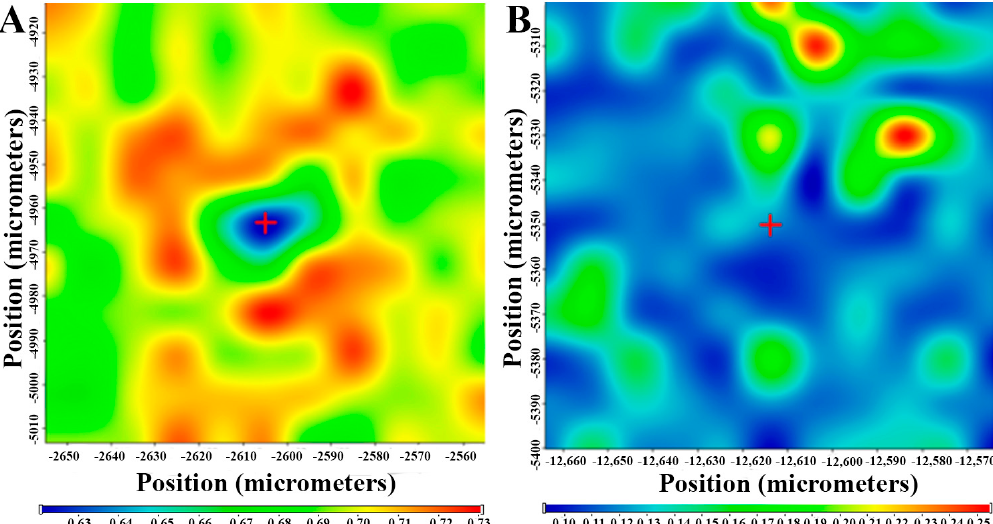
Figure 9. Intensity changes in Raman chemical maps indicating the ( A ) shifting at 1305 nm of physical mixture and ( B ) polymeric micelle; color intensity: blue—extinction of peak at 1305 nm, red— existence of peaks at 1305 nm.